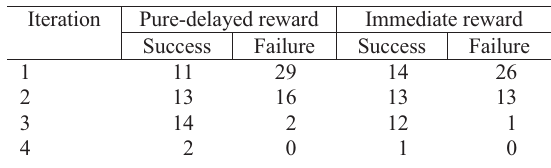
Table 2. The number of training iterations for two reward schemes when 𝑛 equals 6